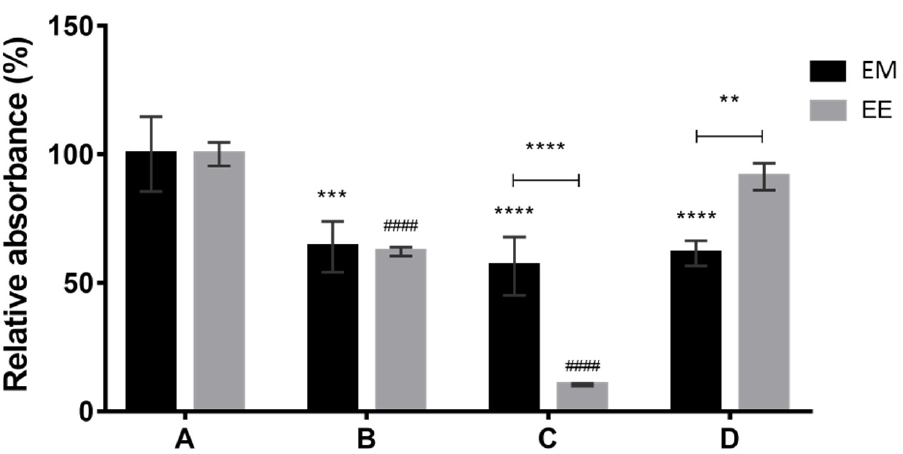
Figure 3. Relative absorbances (%) obtained from the sum of the absorbance values at the three wavelengths (400, 470, and 500 nm) determined for the extracellular medium (EM) and ethanolic extract of the biomass (EE) in each culture media (A–D) under submerged fermentation conditions with immobilized mycelium on an inert support, after 12 days. Values are the mean ± SD ( n = 3). Statistical analysis was performed for culture medium samples, ethanolic samples, and between each other by two-way ANOVA (** p < 0.01, *** p < 0.001, **** p < 0.0001 and #### p < 0.0001).